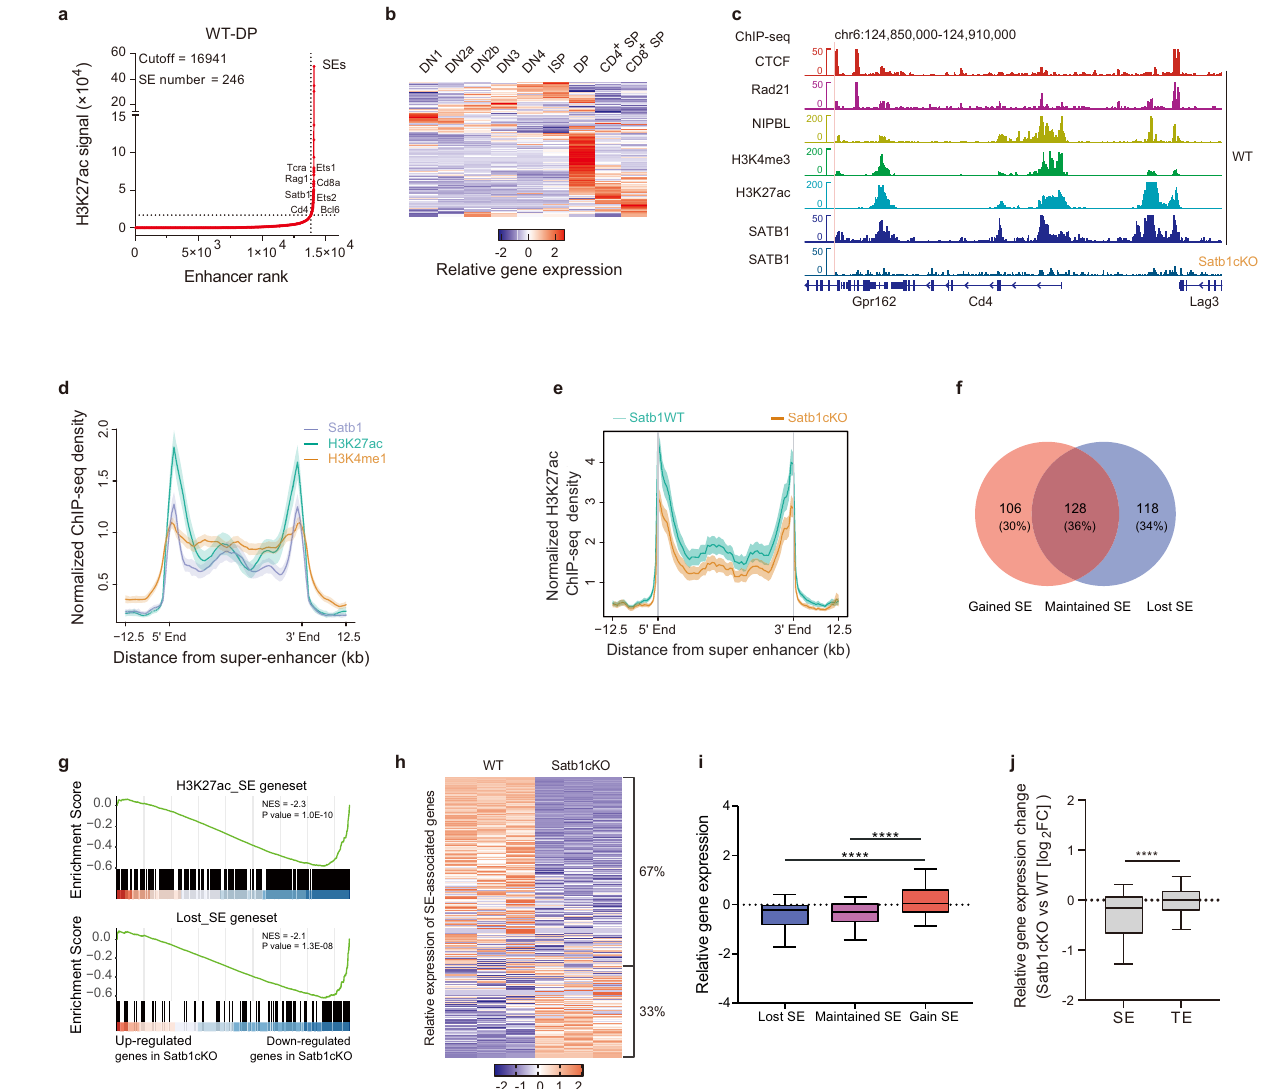
Fig.2|SATB1bindsandactivatessuper-enhancersofDPthymocytes.a Hockey- stick plots showing super-enhancers based on normalized H3K27ac signals and rank in Satb1WT DP thymocytes using the ROSE algorithm. Some super-enhancer- associated genes are highlighted. The H3K27ac ChIP-seq data are from dataset DRP003376 28 . b Heatmap showing relative expression of super-enhancer- associated genes during the differentiation from DN1 to SP thymocytes. Gene expression data are derived RNA-seq data from ImmGen datasets (GSE109125). c NormalizedH3K27ac,H3K4me3,CTCF,Rad21,Nipbl,andSATB1ChIP-seqpro fi les at the Cd4 locus in WT DP cells and the SATB1 ChIP-seq in SATB1-de fi cient thy- mocytes ( Satb1 f/f × CD4 -cre). H3K27ac and H3K4me1 ChIP-seq data are from DRP003376 28 ; Satb1 ChIP-seq in WT DP from GSE90635 25 ; H3K4me3 ChIP-seq, GSE21207 43 ; Rad21 and Nipbl ChIP-seq, GSE48763 44 ; CTCF ChIP-seq, GSE141223 45 . d LineplotdisplayingH3K27ac,H3K4me1,andSATB1ChIP-seqsignaldensityatWT DPsuper-enhancerregions.Datarepresentthemean±SEMChIP-seqdataaresame as( c ). e Line plot displaying H3K27acsignaldensity in Satb1WT vs Satb1cKO atWT DP super-enhancer regions. Data represent the mean±SEM. f Venn diagram showing super-enhancer changes in DP thymocytes of Satb1cKO mice. H3K27ac ChIP-seq signals in Satb1cKO DP thymocytes were used for SE calling. Gained SE,